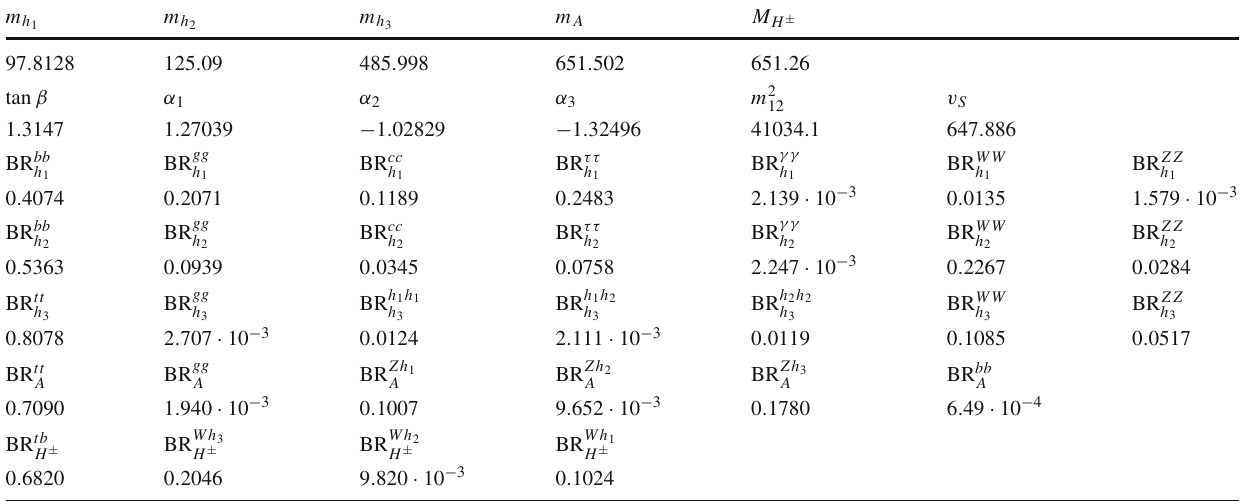
Fig. 8 Allowed ( green ) and excluded ( red ) points considering direct searches ( left ) and flavor physics ( right ) in the M H ± -tan β plane. The magenta star is the best-fit point Table 6 Parameters of the best-fit point and branching ratios of the scalars in the type IV scenario. Dimensionful parameters are given in GeV and the angles are given in